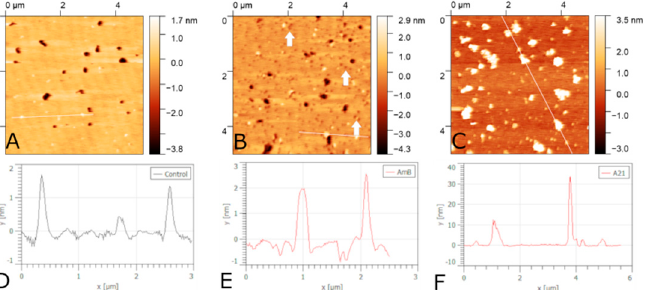
Figure 14. Topographic images of supported lipid bilayers composed of POPC:ESM 1:1 mol:mol + 20 mol% cholesterol in the presence ( B , C ) or absence of polyenes ( A ). Polyenes were added by increments of 0.5 µM until a clear effect was observed. For AmB ( B ) this occurred at 2 µM; for A21 at 5 µM. ( D – F ) show height profiles corresponding to the lines drawn on the topographic image. White arrows indicate regions where nano-defects or lesions are clearly visible.